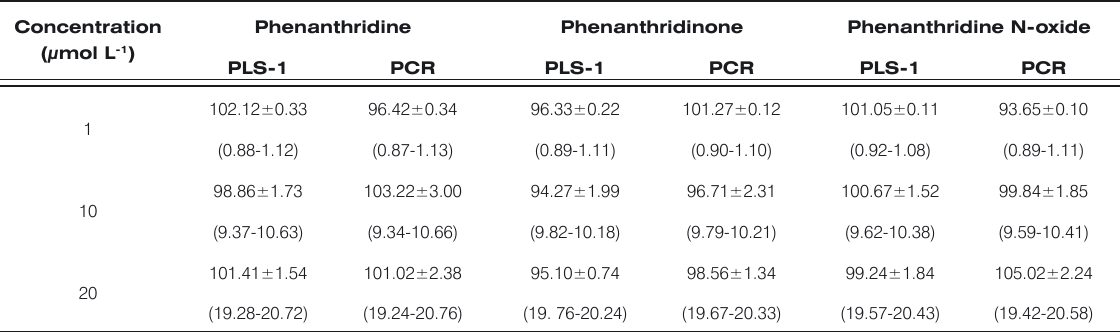
* The data are expressed as mean ± standard deviation. Values in parentheses represent 95% confidence intervals.